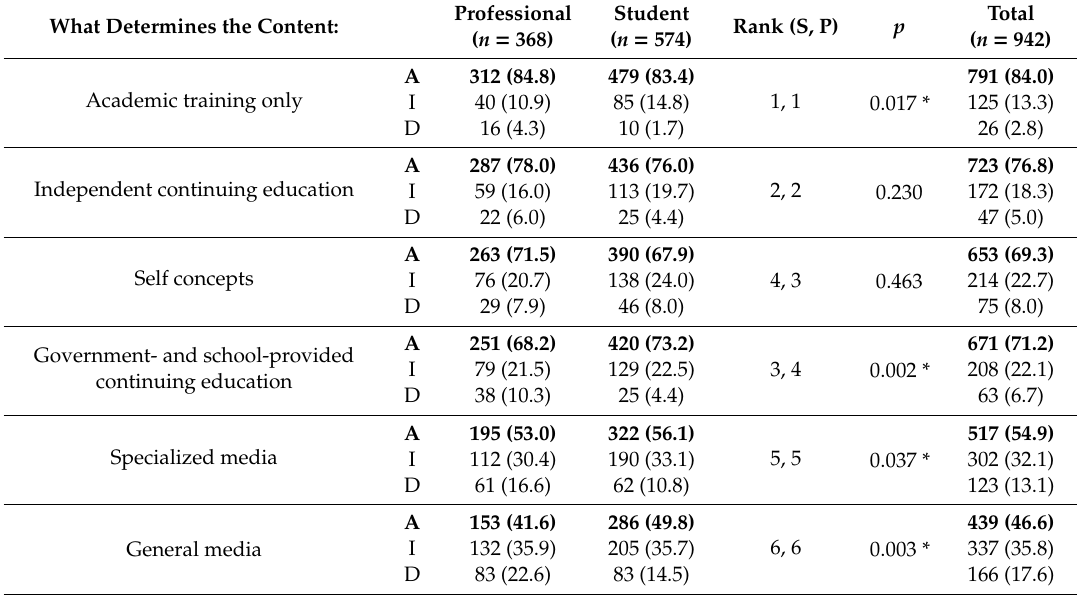
Table 3. Questionnaire on the origin of the concepts and principles that determine the choices of content for a physical education class.